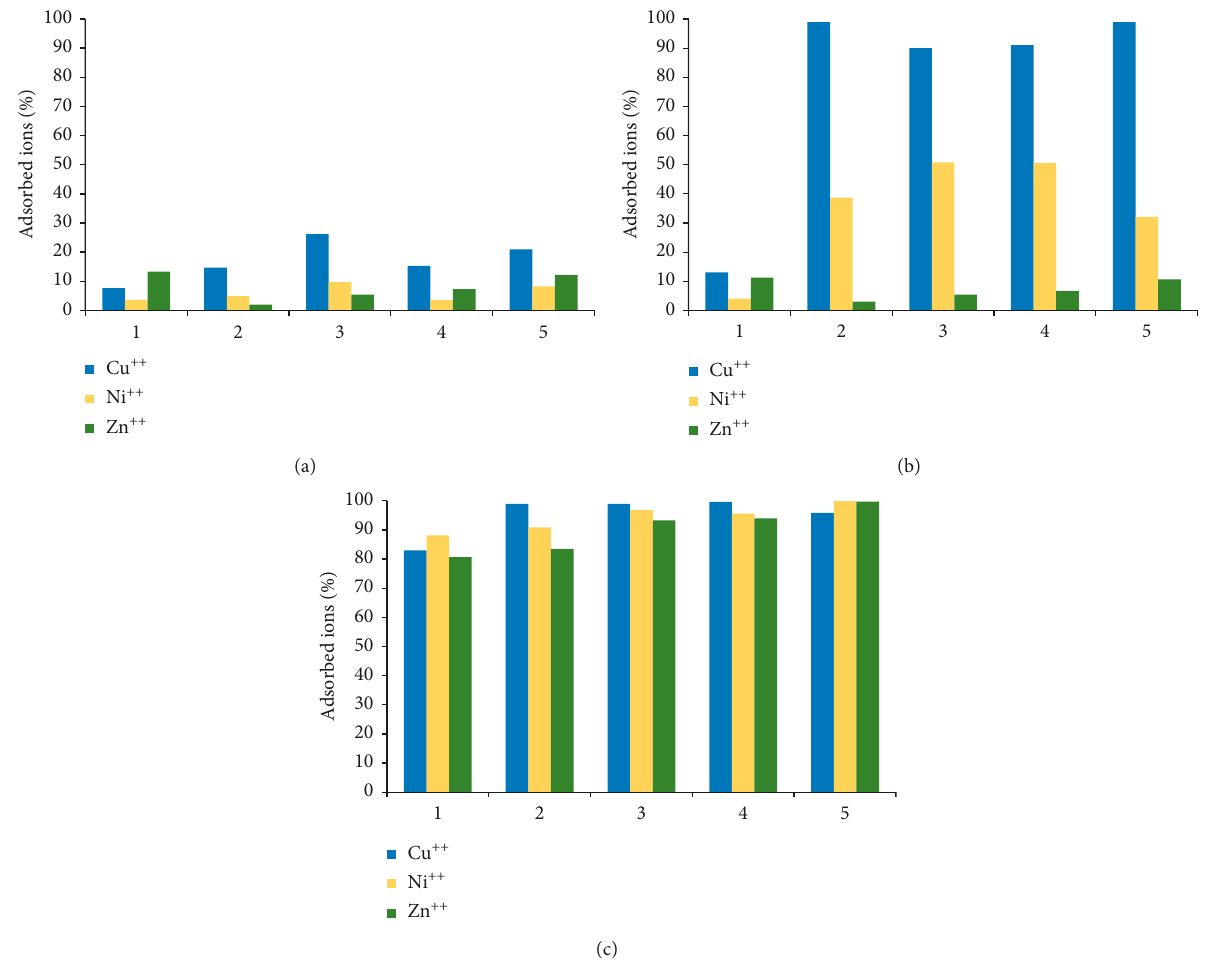
Figure 6: Adsorption (%) on Si c (a), Si c -[BAC-DMEDA] (b), and Si c -[BAC-EDDA] (c) of heavy metal ions dissolved in (1) distilled water,